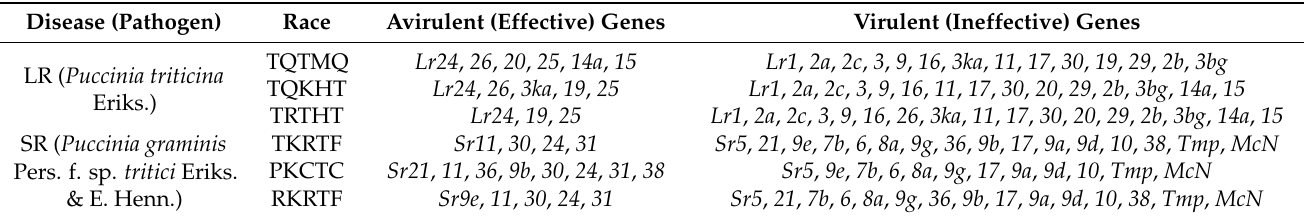
Table 5. Virulence/avirulence pattern of pathogen races used in the study based on the nomenclature by Long and Kolmer [41] for LR and by Roelfs and Martens [42] for SR. Disease (Pathogen) Race Avirulent (Effective) Genes Virulent (Ineffective) Genes LR ( Puccinia triticina Eriks.) SR ( Puccinia graminis Pers. f. sp. tritici